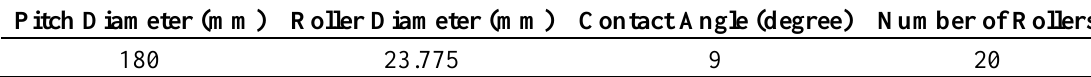
Table 1. Geometric parameters of the roller bearing.